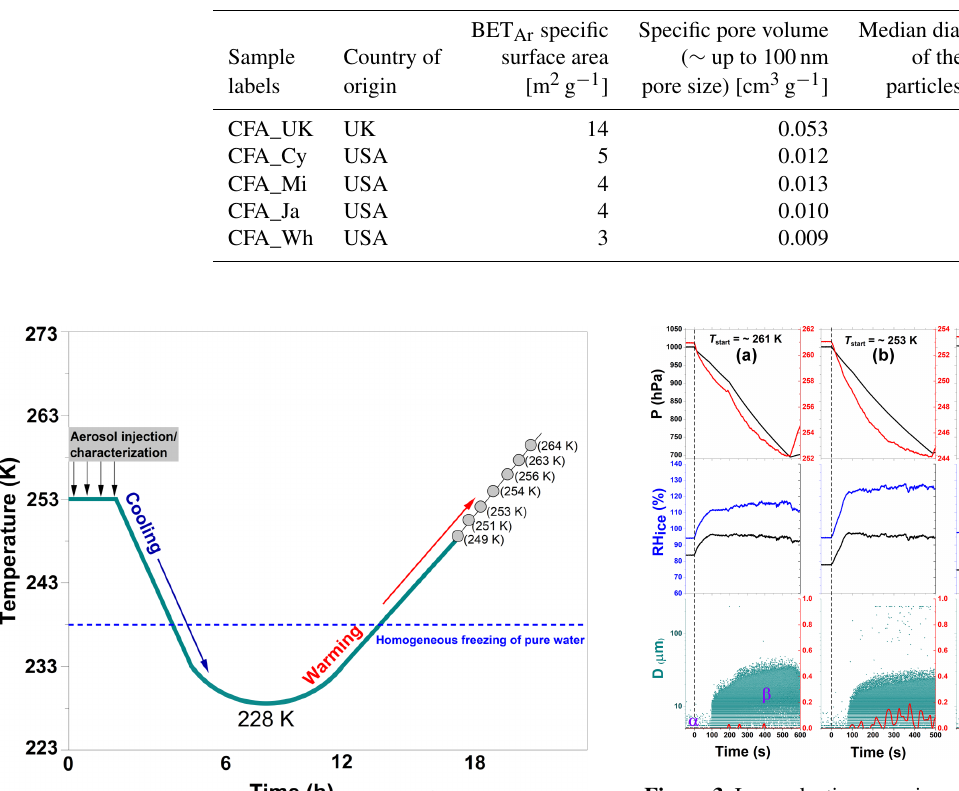
Figure 3. Ice nucleation experiment data for unprocessed CFA_UK particles at 261, 253, 245, and 228K start temperatures ( T start ) . These data correspond to experiments 2, 3, 4, and 1 in Table 2, re- spectively. Each column ( a , b , c , and d ) has three plot panels – top, middle, and bottom. The top panels show the pressure (hPa, black) and the mean gas temperature (K, red) profiles of the AIDA aerosol and cloud simulation chamber throughout the duration of the exper- iment. The middle panels indicate the changes in the relative humid- ity with respect to ice (RH ice , blue) and water (RH w , black), both in percent (%). The bottom panels illustrate the data for the optical size measurements from the OPCs (green dots). Greek letters point to the various types of particles detected: CFA seed aerosol particles are represented by α , cloud droplets represented by β , and ice crys- tals represented by γ (see text for details). The bottom panels also include the ice-activated fraction (%) of the aerosol particle popu- lation ( f ice , red line). In column (c) (bottom panel, shaded region), there is a sudden increase in the number concentration of ice par- ticles due to the onset of homogeneous freezing. The ice-activated fraction due to the homogeneous freezing of water droplets is de- noted by the dashed red line to separate it from the heterogeneous immersion freezing